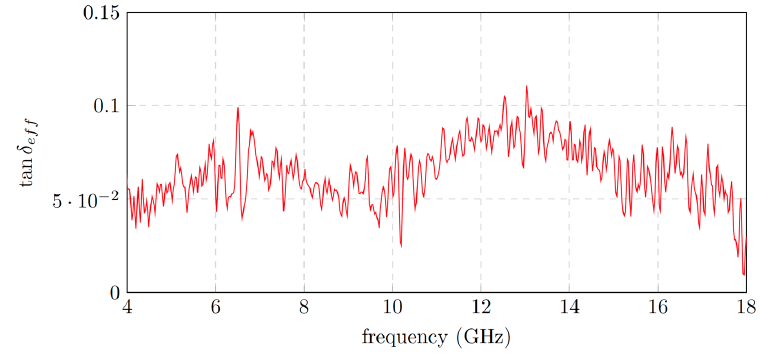
Figure 12. Extracted apparent tan δ of a 0.2 mm pitch ACP, t = 60 µm.